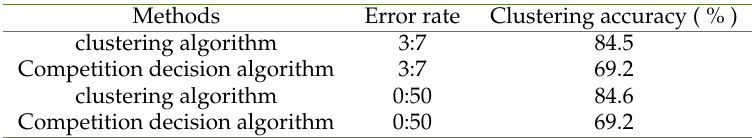
Table 1. Determination results.